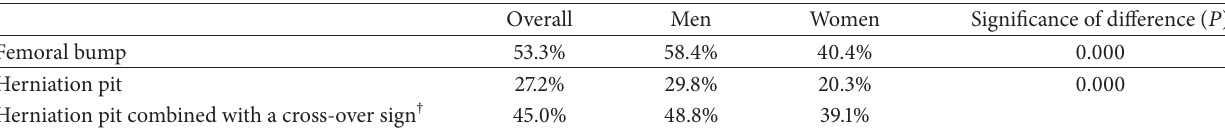
Table 1: Incidence of femoral bump and herniation pit.